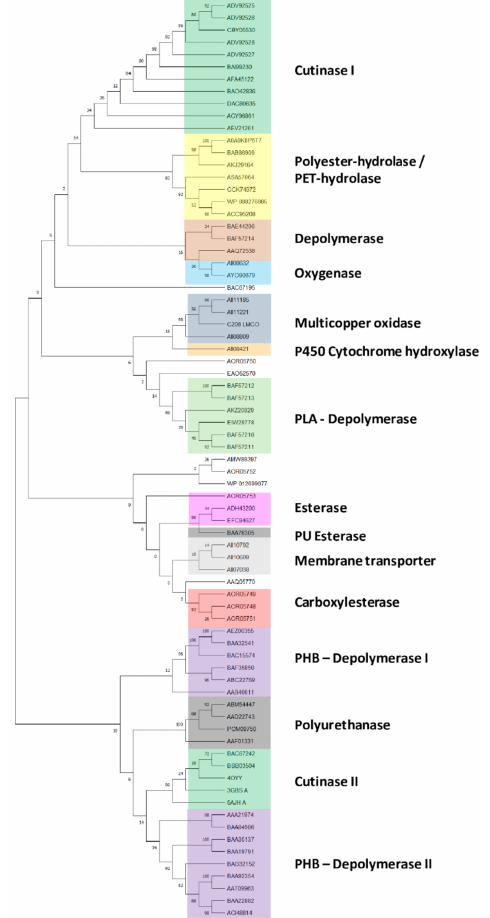
Figure 1. Clusterization tree of unique input gene products belonging to different microorganisms (retrieved from PlasticDB database, literature data, omic studies, and functional analyses for the capability of degrading at least one type of plastic) divided into fifteen clades: cutinase I (clade I), polyester-hydrolase/PET-hydrolase (clade II), depolymerase (clade III), oxygenase (clade IV), multi- copper oxidase (clade V), cytochrome P450 hydroxylase (clade VI), PLA-depolymerase (clade VII), esterase (clade VIII), PU esterase (clade IX), membrane transporters (clade X), carboxylesterase (clade XI), PHB-depolymerase I (clade XII), polyurethanase (clade XIII), cutinase II (clade XIV), and PHB-depolymerase II (clade